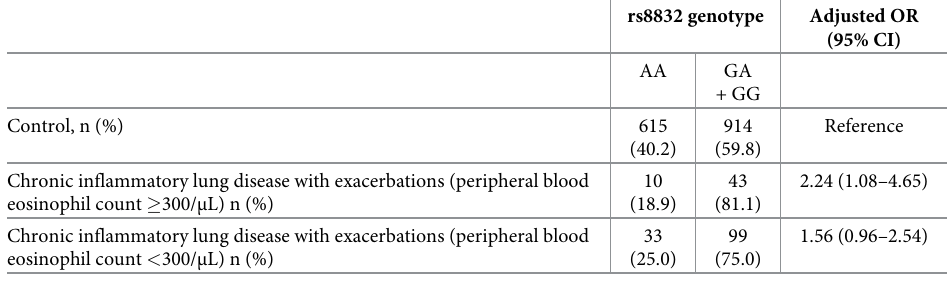
OR: odds ratio. The ORs were calculated for the presence of the rs8832 G allele using a multinomial logistic regression model. Values were adjusted for sex, age and smoking status in the analysis. Participants with increased eosinophil counts included 25 patients with asthma, 9 patients with COPD, and 9 patients with